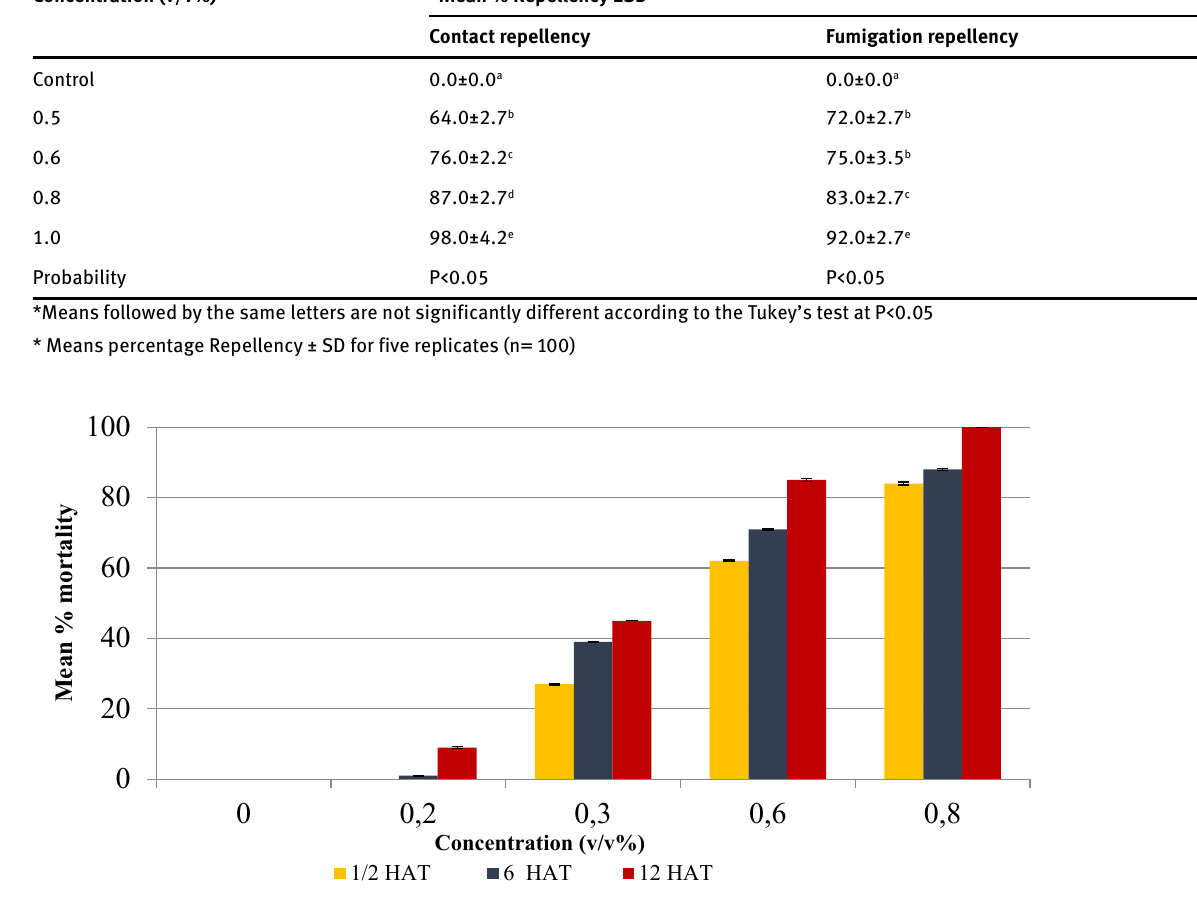
Figure 3: Mean percentage mortality of oil from P. dioica on C. maculatus after 1/2, 6 and 12 hours in the contact toxicity test HAT- Hours After